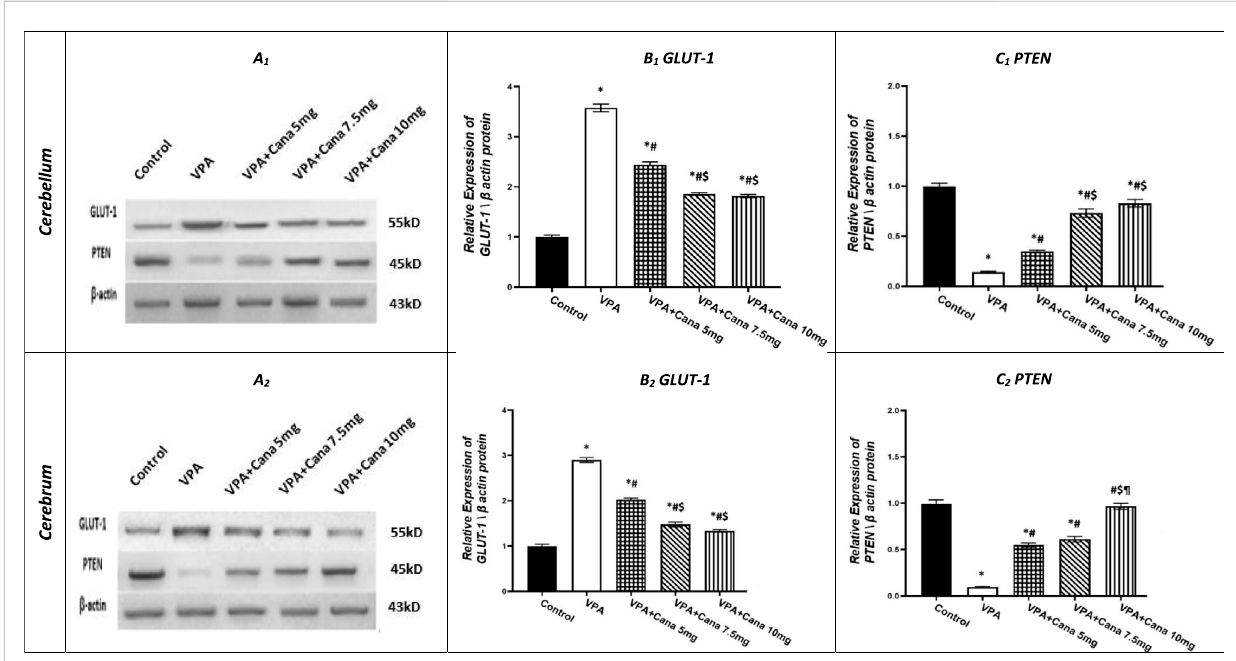
FIGURE 7 Effect of canagli fl ozin (5 mg/kg, 7.5 mg/kg, and 10 mg/kg) on the expression of GLUT-1 (B) and PTEN (C) protein in the cerebellum and cerebrum tissuesofVPA-inducedautisminrats.VPA,valproicacid;Cana,canagli fl ozin.Resultsareexpressedasmean±S.E.Mandanalyzedusingone-wayANOVA, followed by Tukey ’ s post hoc multiple comparisons test. * Compared to the corresponding control group at p < 0.05, # compared to the corresponding VPA group at p < 0.05, $ compared to the corresponding VPA + Cana (5 mg/kg) group at p < 0.05, ¶ compared to the corresponding VPA + Cana (7.5 mg/kg) group at p < 0.05, n = 8, for all groups except for the control group, n =